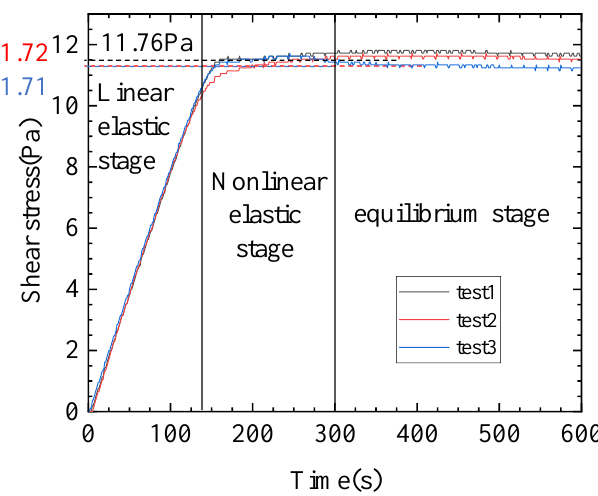
Figure 1. Comparison of the three yield stress measurements. For the Toorman model, its parameter C can be obtained from the hysteresis loop curve. When the gel is in the pre-yielding state, it can be considered that its structural parameters remain constant with λ = 1. As the gel starts to flow, λ starts to decrease from 1. When λ = 1, the following relationship can be derived from the Toorman model: